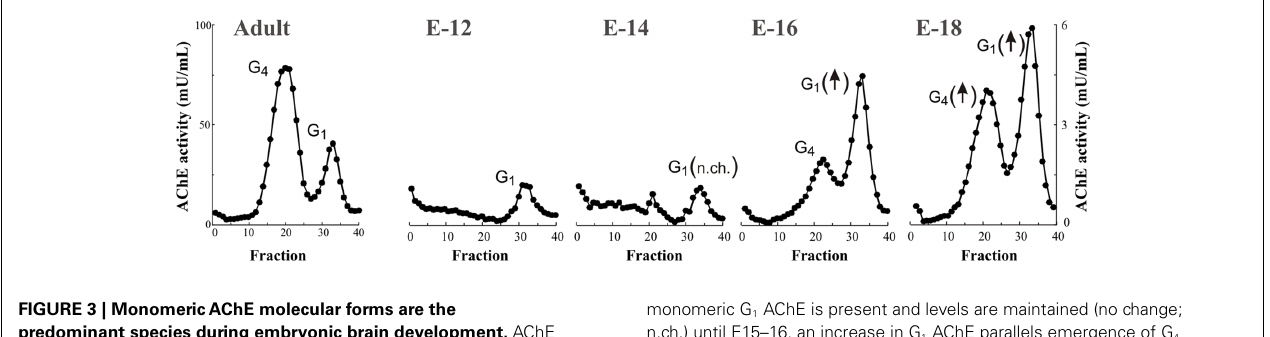
FIGURE 3 | MonomericAChE molecular forms are the predominant species during embryonic brain development. AChE activity was extracted from rat (Sprague-Dawley) cerebral cortex at embryonic day 12 (E14), 14 (E14), 16 (E16), and 18 (E18) and at 3months of age (Adult), and AChE forms were separated by sucrose density gradient (see Figure 1 ). At early embryonic stage only light